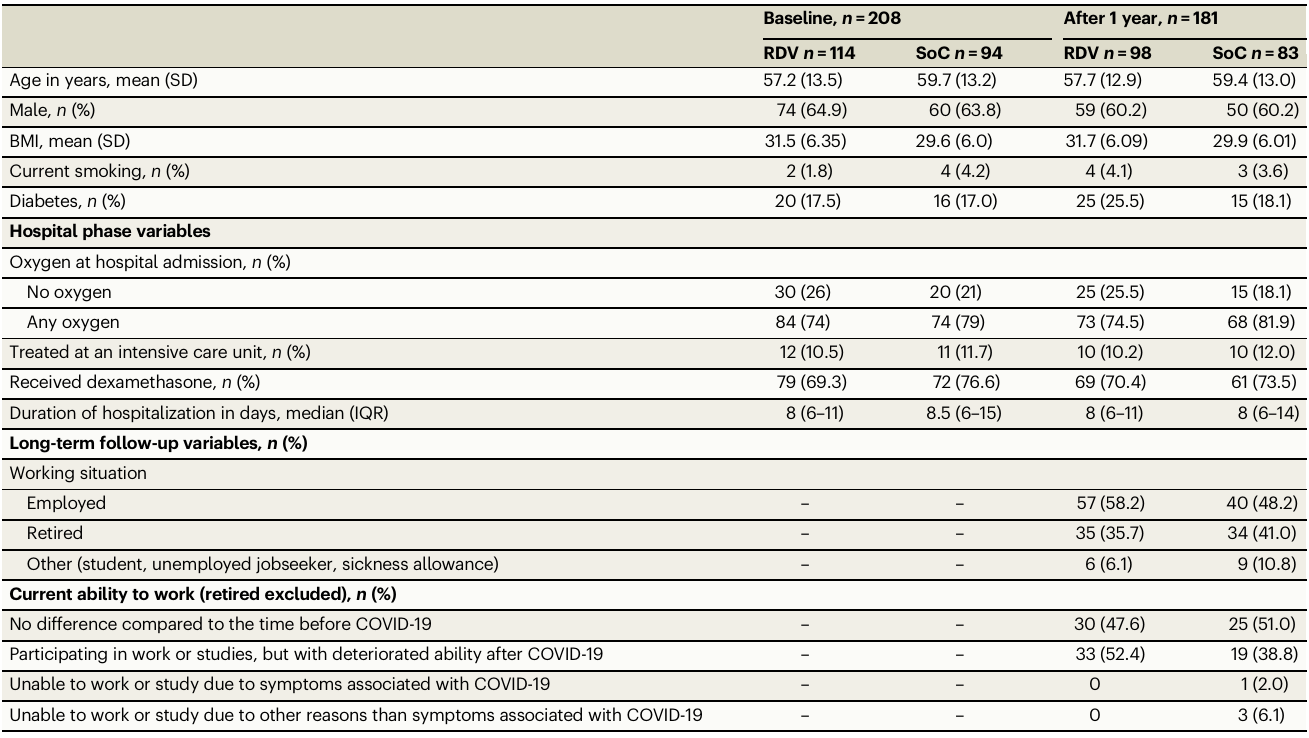
Table 1 | Characteristics of participants in a randomized controlled trial between remdesivir (RDV) and standard of care (SoC) arms at baseline and long-term follow-up after 1 year from randomization